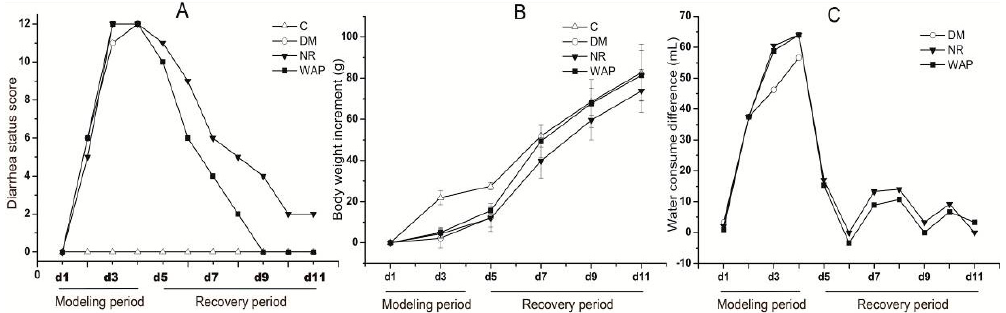
Figure 2. E ff ects of WAP on total diarrhea status scores ( A ), weight increment ( B ), the di ff erence in water consumption ( C ). C, control group; DM, antibiotic-associated diarrhea group; NR, natural recovery group; and WAP, Astragalus polysaccharide group. Data are expressed as means ± S.D. ( n =